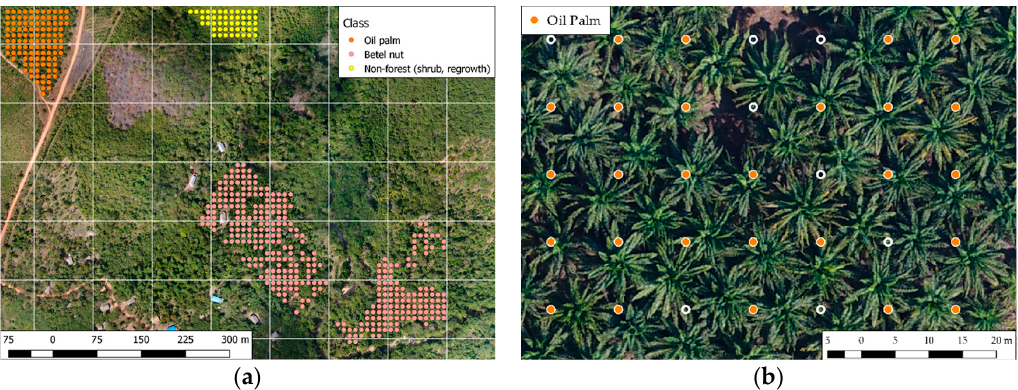
Figure 5. Dot-grid photointerpretation method showing an example of reference data collected for ( a ) oil palm, betel nut, and shrub (UAV, Area A, 2017); ( b ) oil palm trees were identified with orange dots if they fell within the circle of palm canopy (UAV, Area B, 2017).